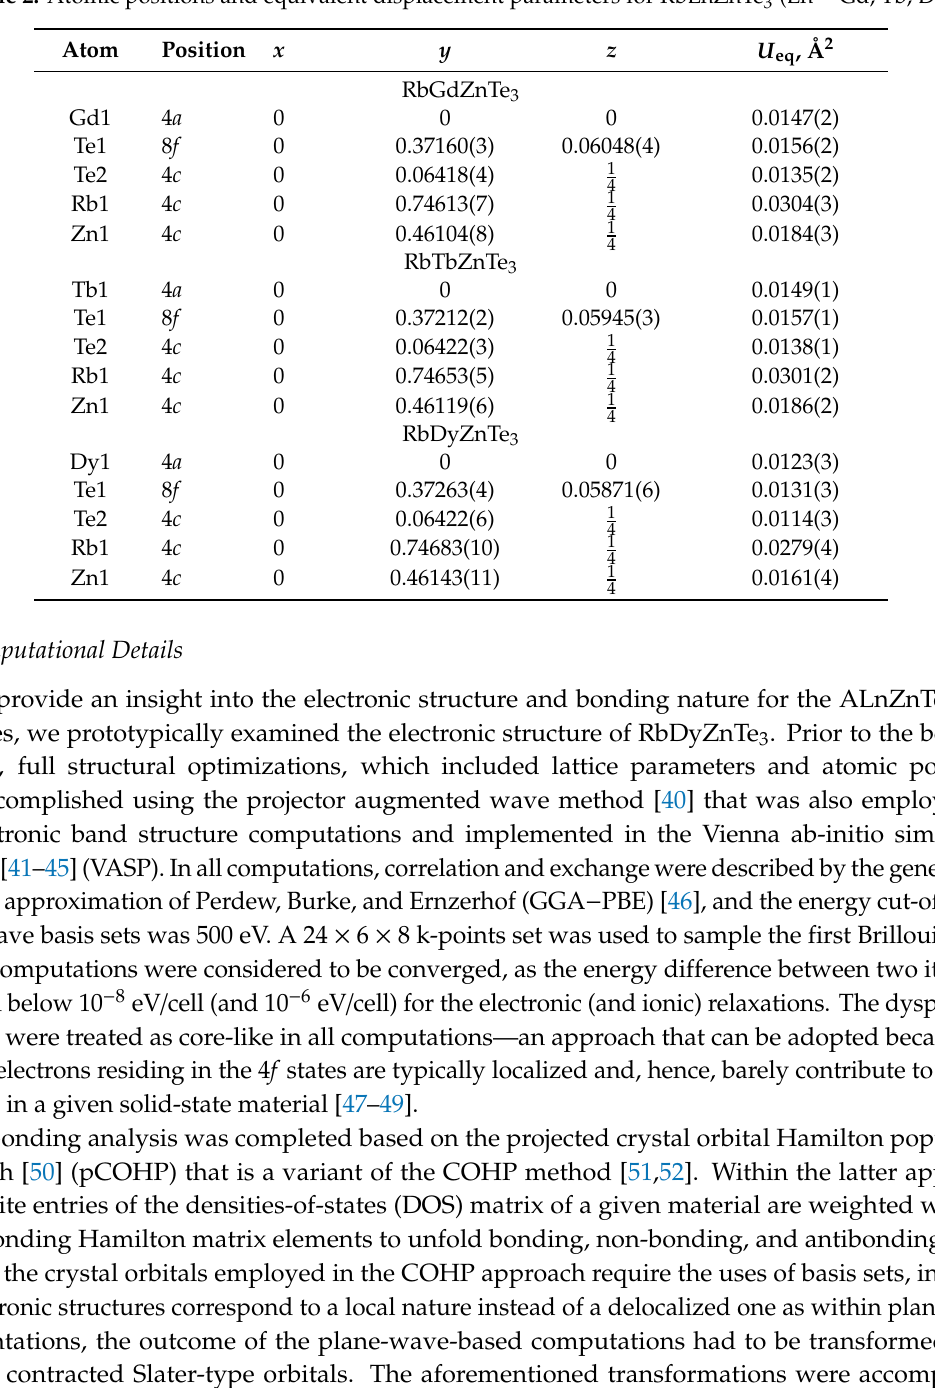
Table 2. Atomic positions and equivalent displacement parameters for RbLnZnTe 3 (Ln = Gd, Tb,